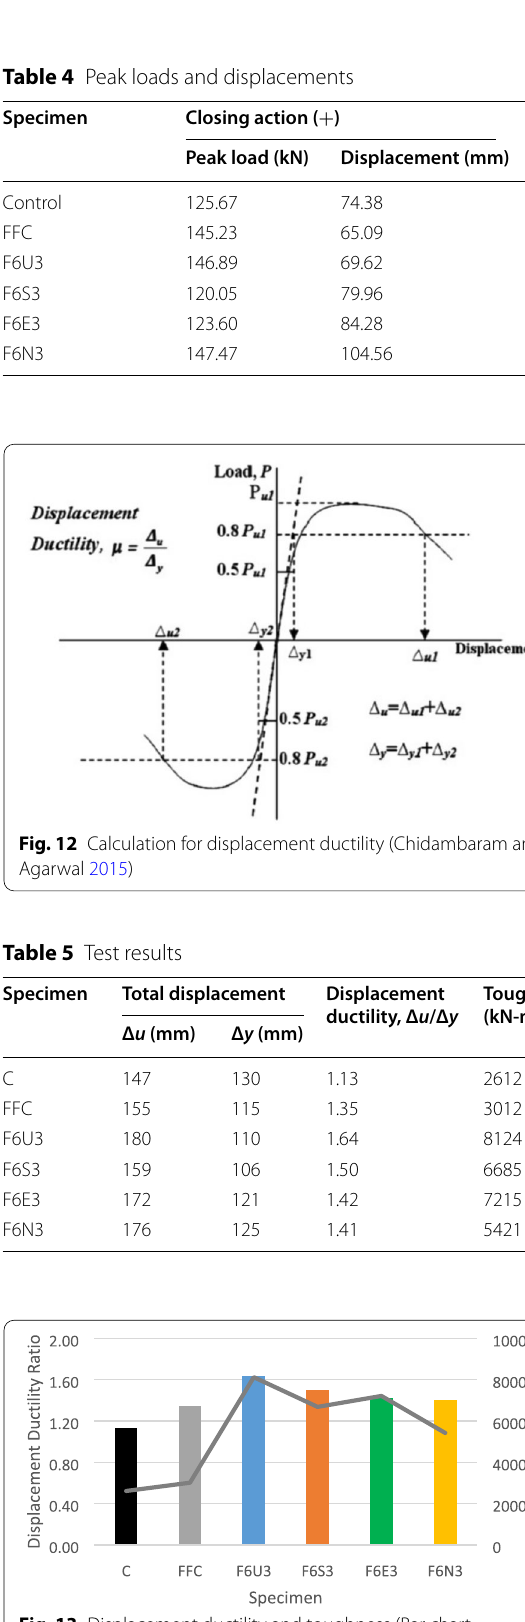
Fig. 13 Displacement ductility and toughness (Bar chart: displacement ductility ratio, Line graph: toughness)